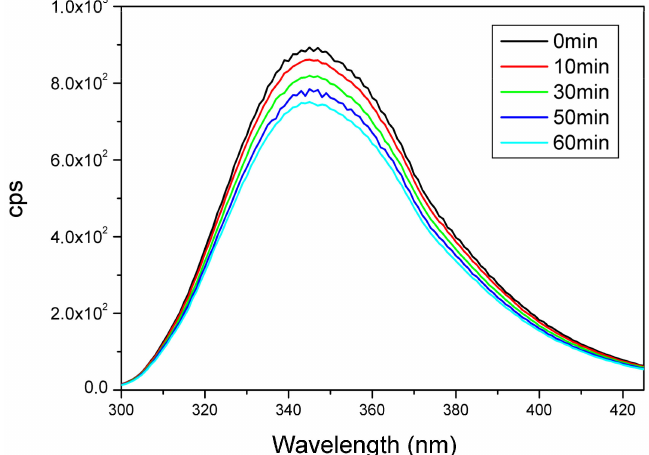
Figure 7. Trp fluorescence spectrum of peptide Ac-c(CWAGC)-NH 2 after irradiation at 280 nm —: 0 min, —: 10 min, —: 30 min, —: 50 min, —: 60 min.